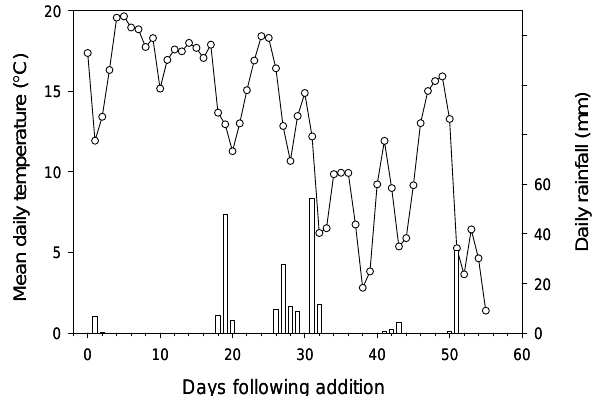
Figure 1. Daily mean air temperature and rainfall during the